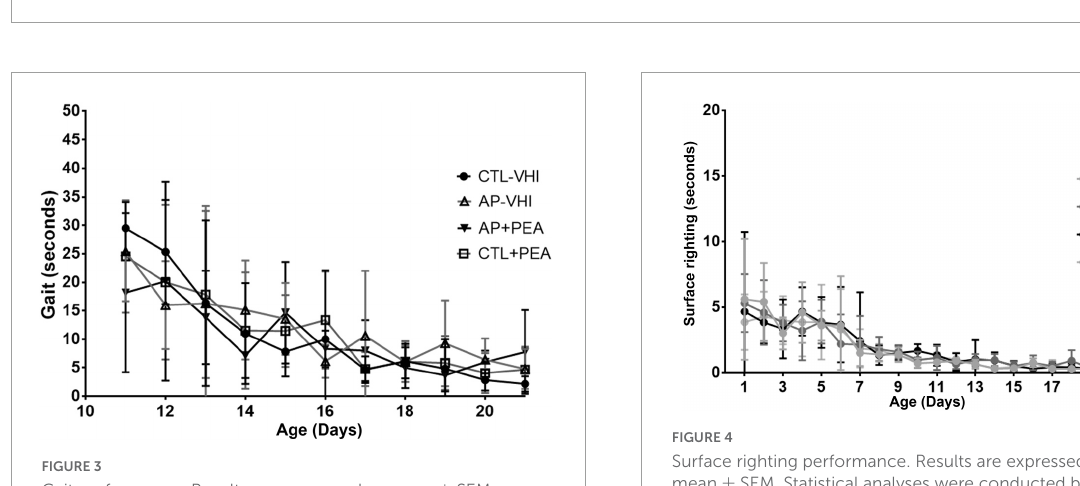
FIGURE4 Surface righting performance. Results are expressed as mean ± SEM. Statistical analyses were conducted by two-way mixed ANOVA. CTL-VHI, control rats treated with vehicle; PA-VHI, rats subjected to PA and treated with vehicle; PA + PEA, rats subjected to PA and PEA treatment; CTL + PEA, control rats treated with PEA.